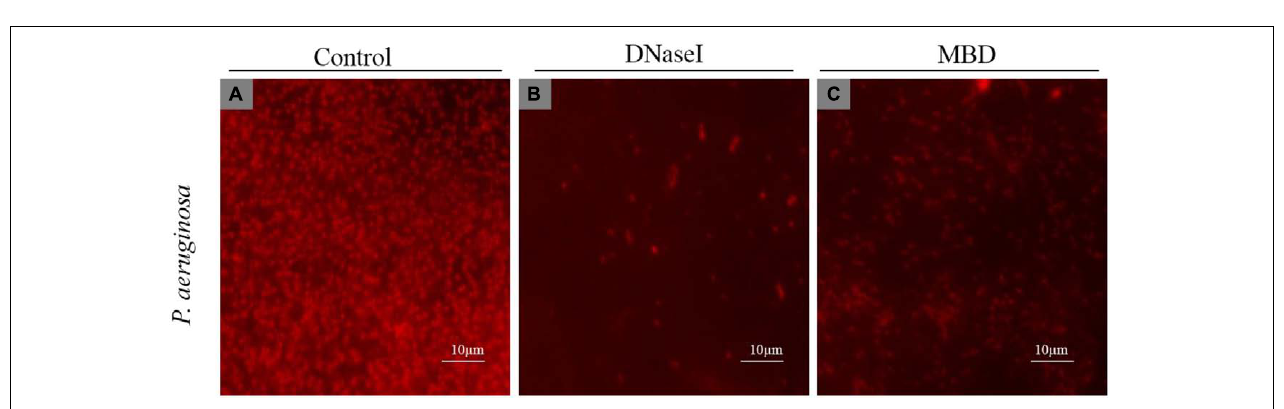
FIGURE 7 | Fluorescent microscopy image of P. aeruginosa eDNA. Propidium iodide (PI) stained eDNA in red. (A) Control, (B) DNaseI treated, (C) MBD